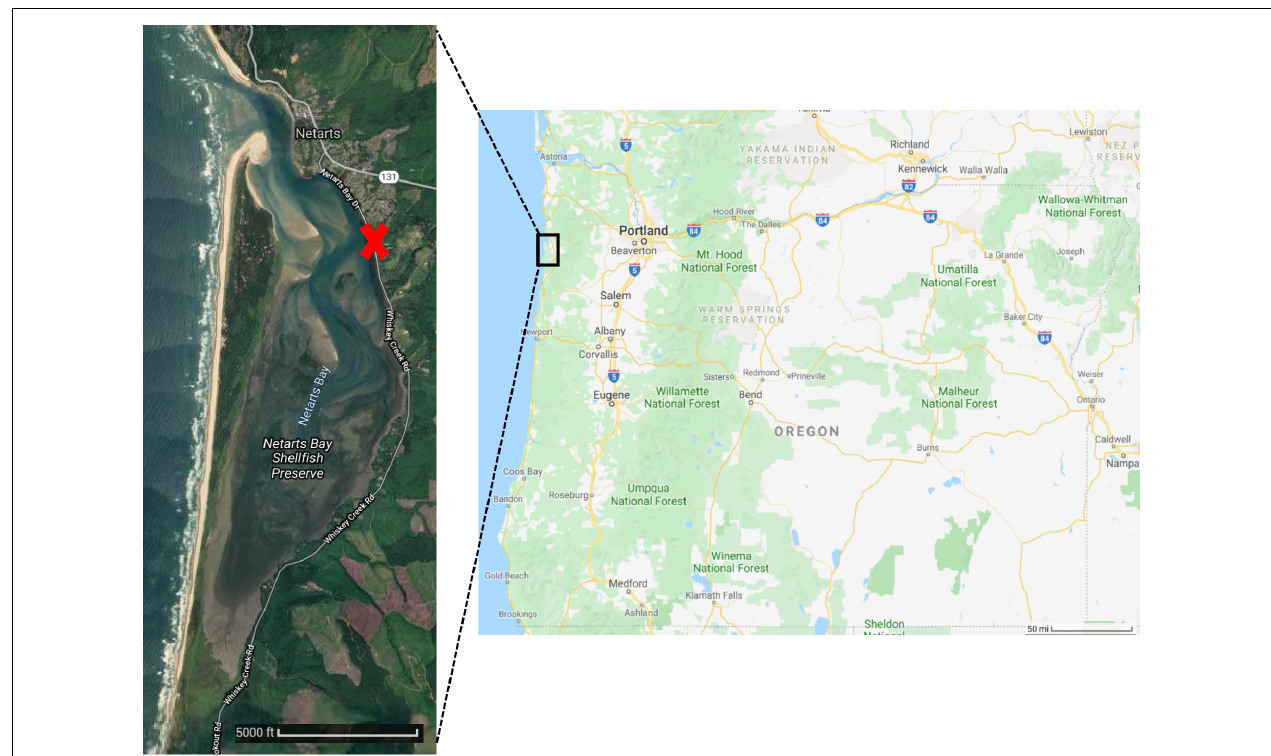
FIGURE 1 | Oregon state map (Right) and satellite imagery of Netarts Bay (Left) . Red X marks site of Whiskey Creek Shellfish Hatchery (WCSH). Images courtesy of Google